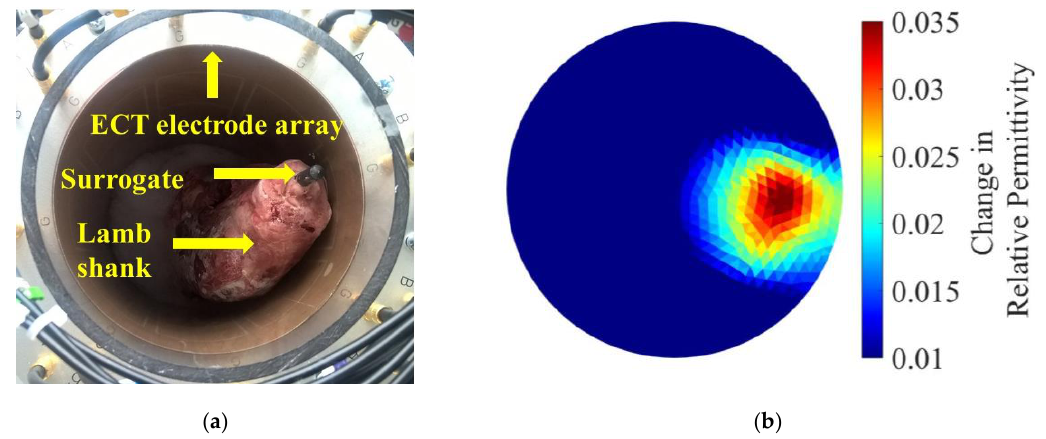
Figure 16. ( a ) The lamb shank with an embedded prosthesis phantom was scanned by the ECT electrode array. ( b ) The change in electrical permittivity distribution with respect to the empty baseline of air (i.e., empty ECT electrode array) is